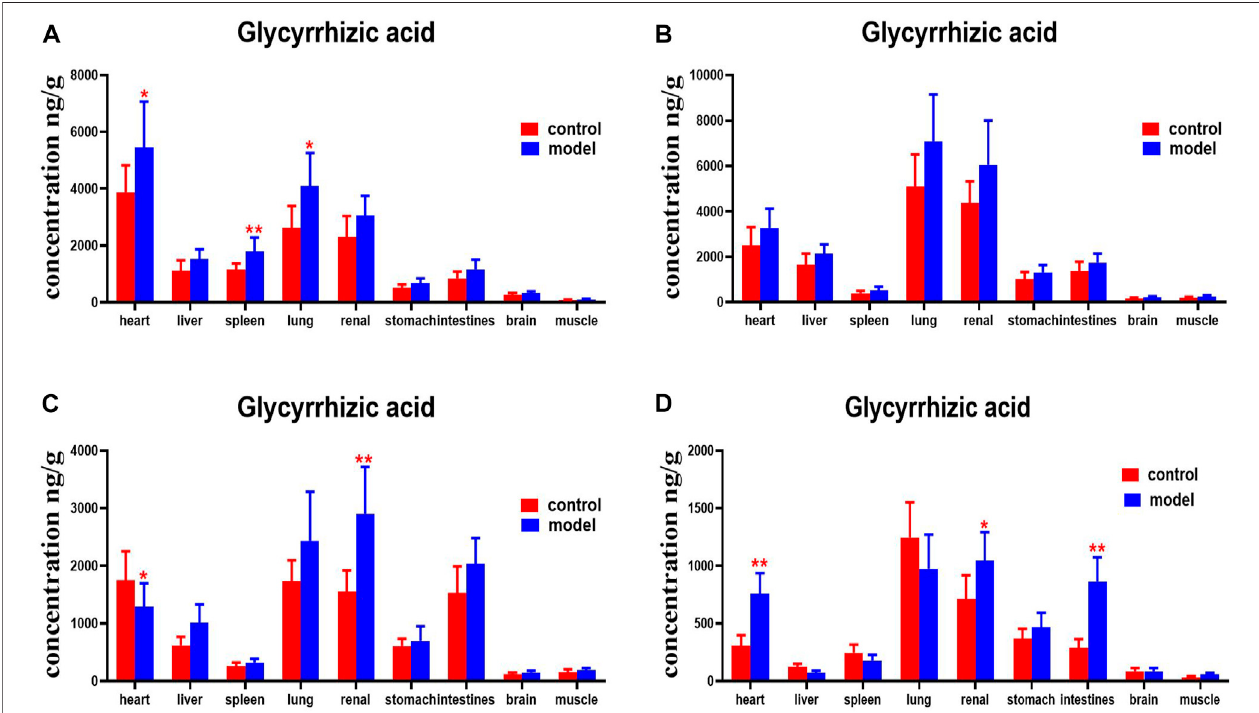
FIGURE 15 | Content of glycyrrhetinic acid in different mouse tissue homogenate of the normal and DN models at four different time points after intragastric administration of HQD (x±SD, n =8), (A) 30 min, (B) 2 h, (C) 4 h, (D) 8 h. Ps: * P < 0.05, ** P < 0.01 vs normal group.